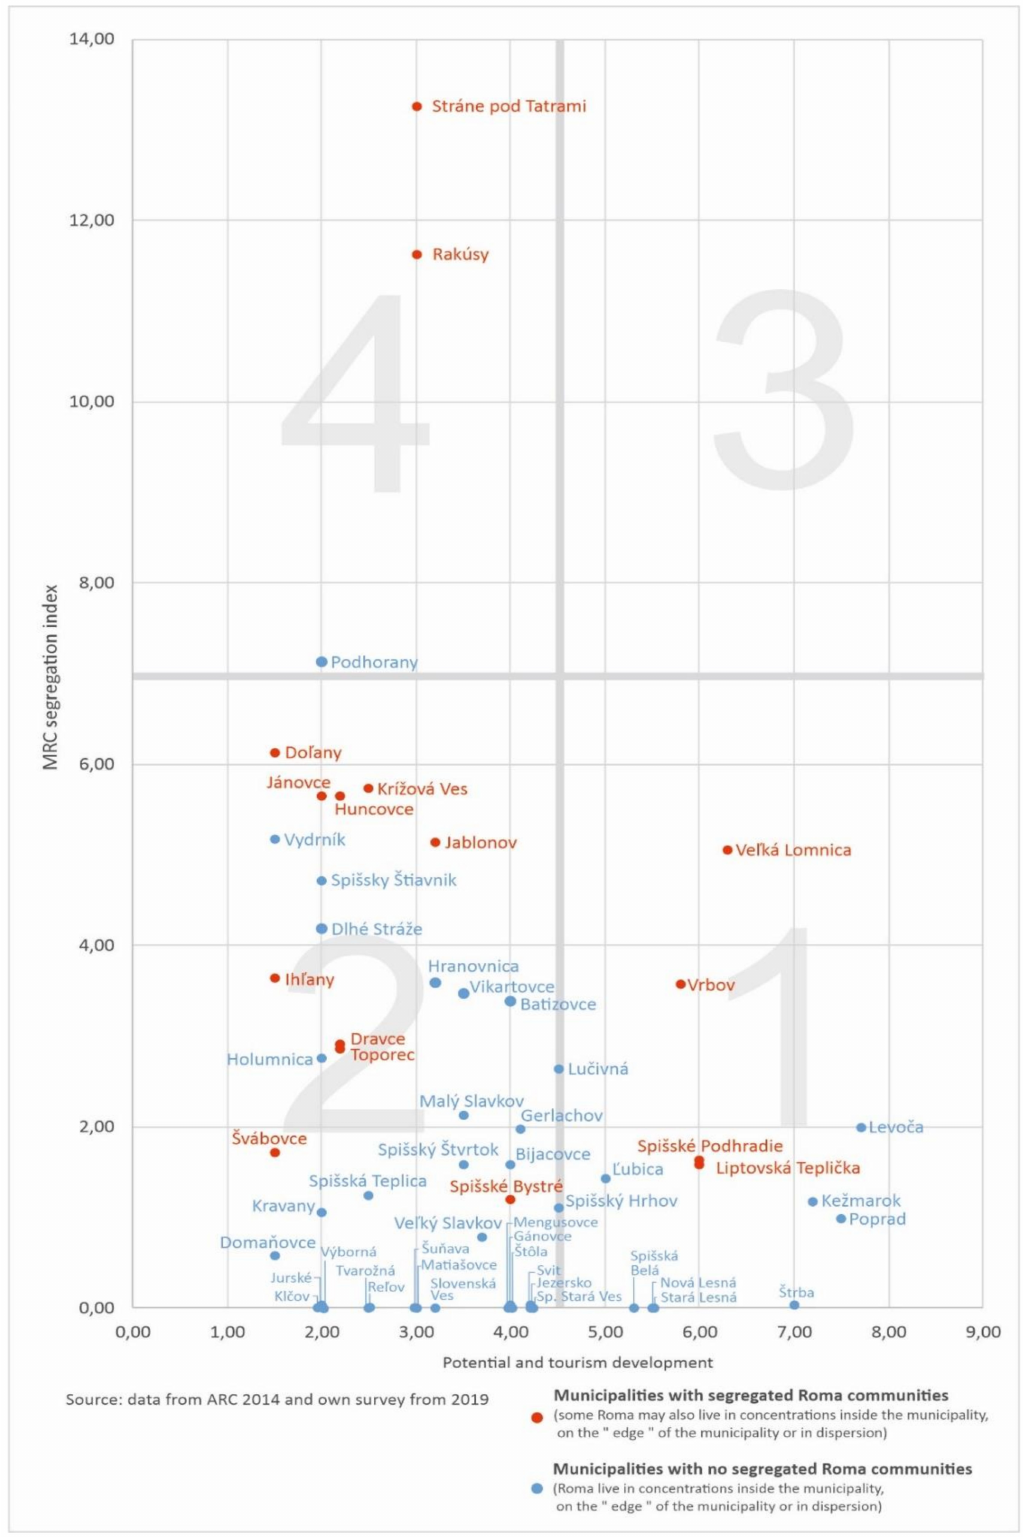
Figure 5. MRC segregation index in the municipalities of the Central Spiš region. Source: own evaluation based [45,47] for more see